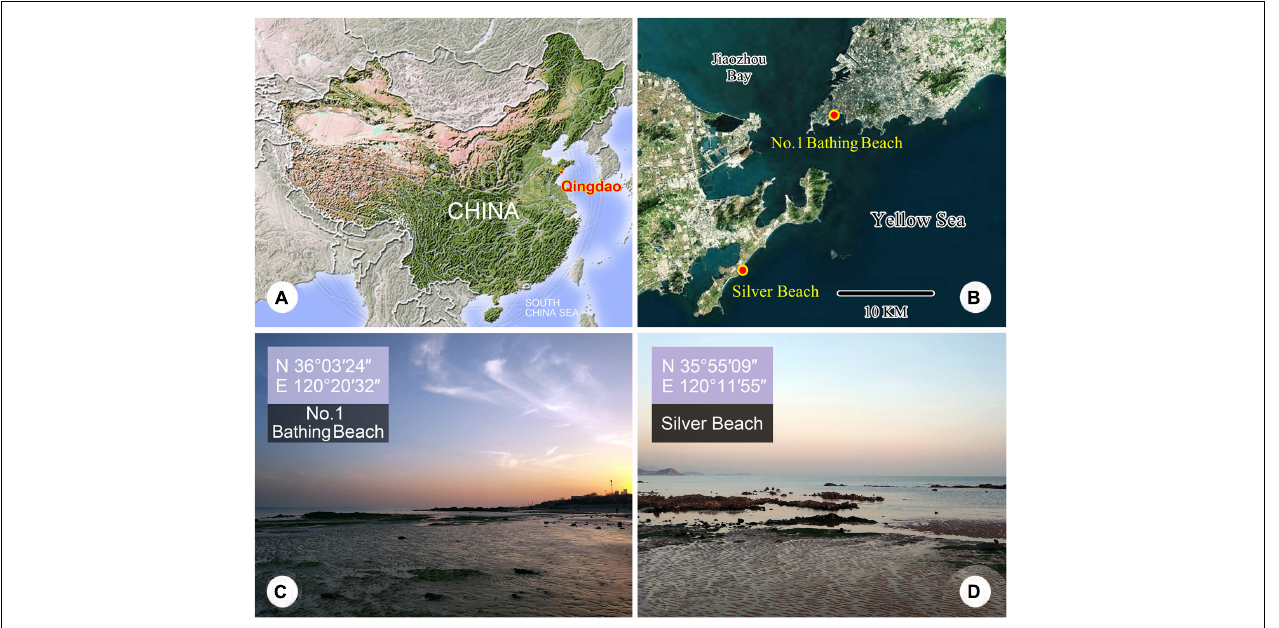
FIGURE 1 | (A–D) Maps and photographs of the sample sites. (A) Location of Qingdao. (B) The dots indicates the locations of the two sample sites. (C) The intertidal zone of the No. 1 Bathing Beach. (D) The intertidal zone of Silver Beach.